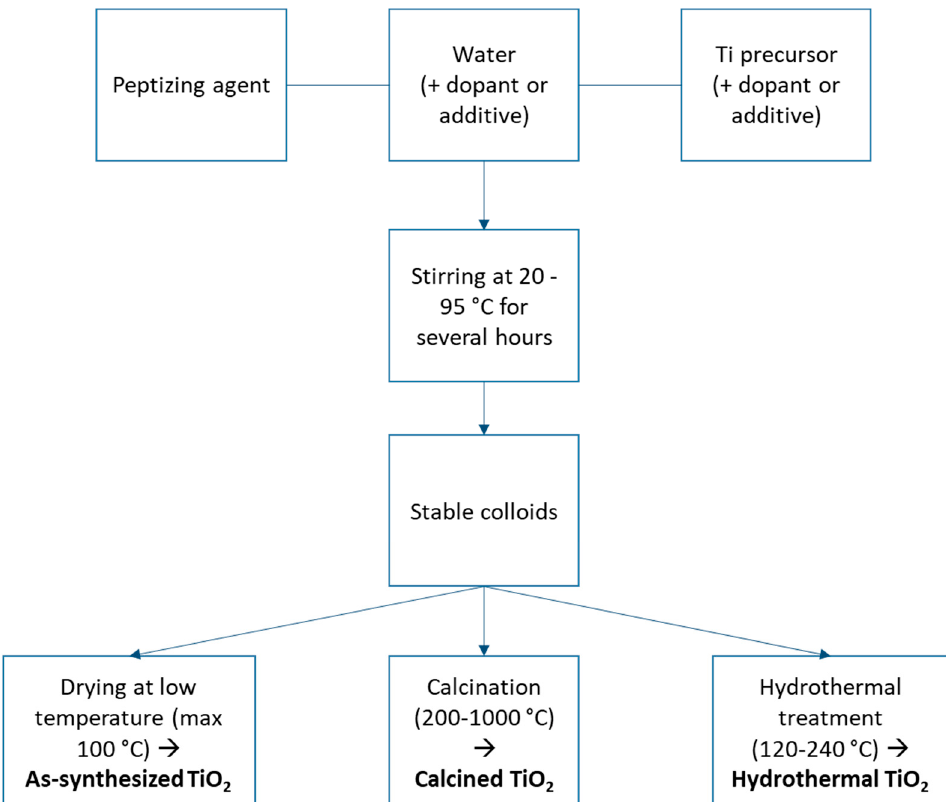
Figure 4. General scheme of the sol–gel TiO 2 colloidal aqueous synthesis.